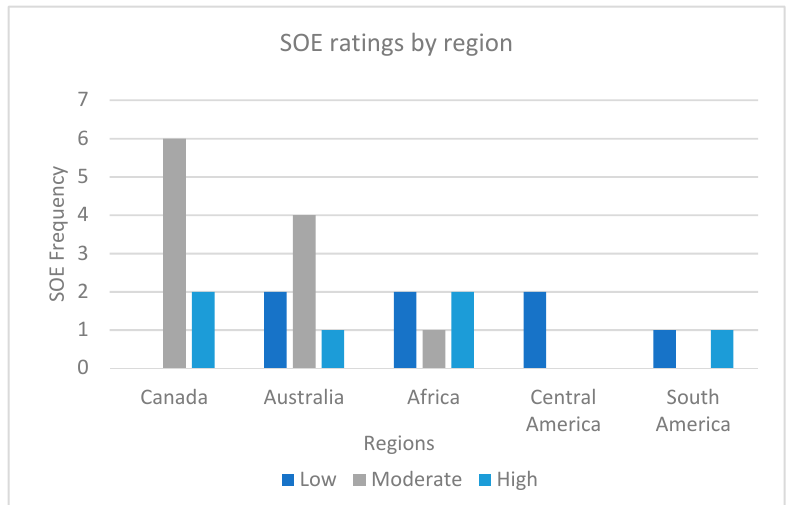
Figure 2. SOE ratings by region.